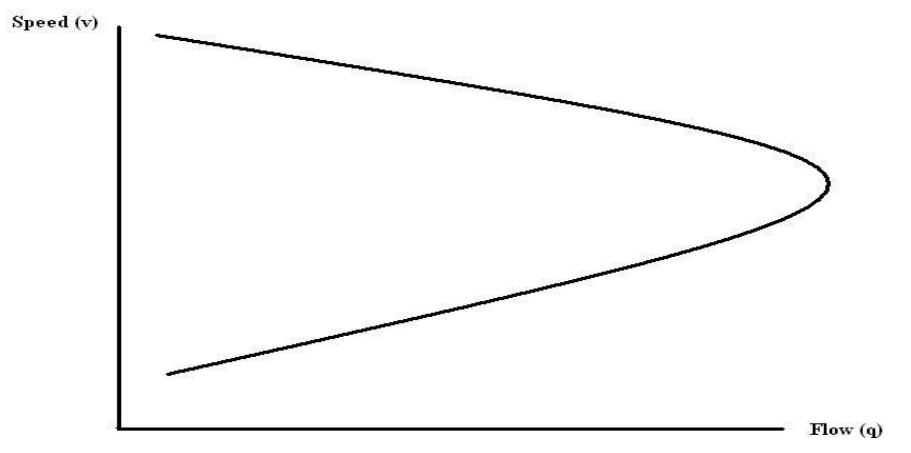
Figure 5. Speed - flow relationship (The Highway Capacity